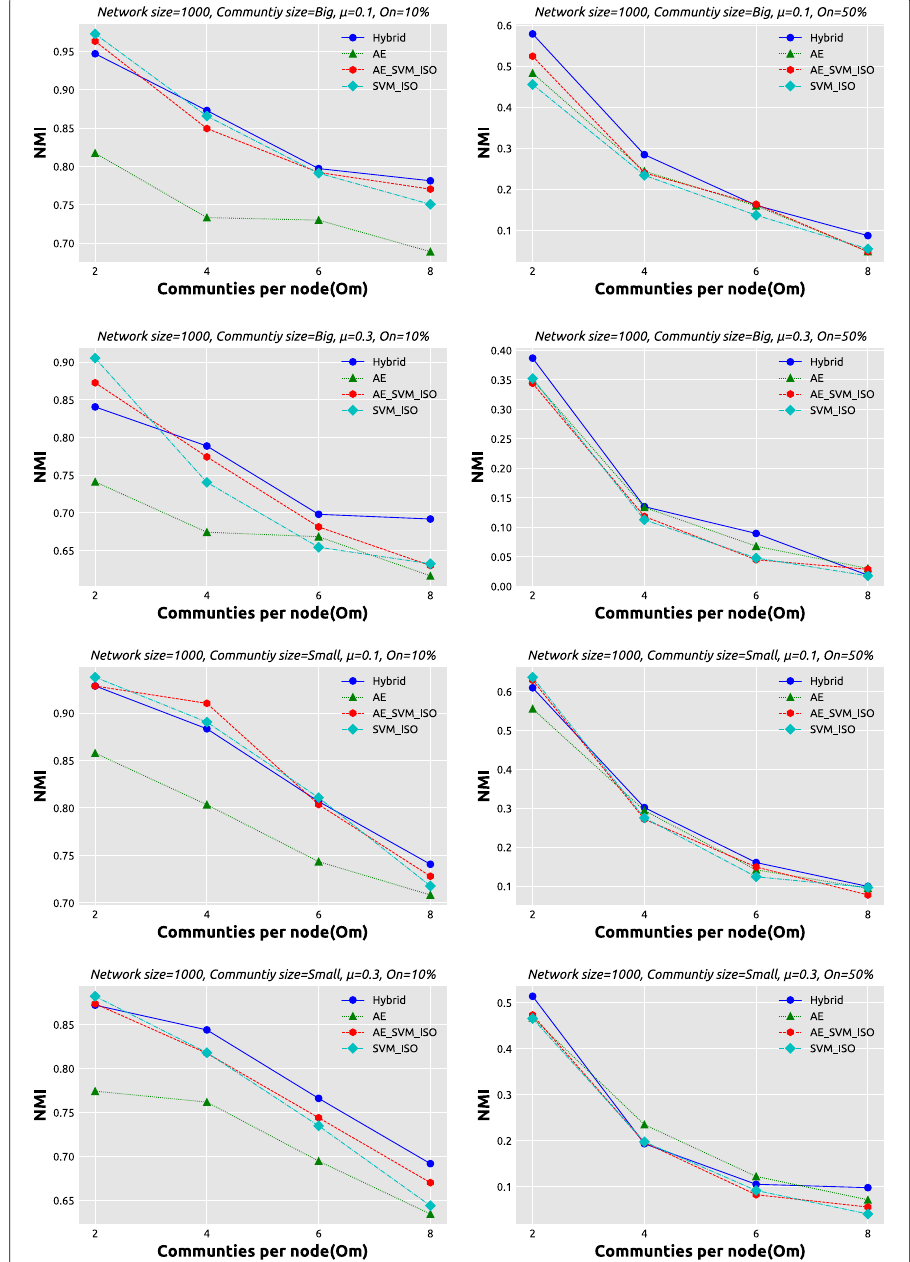
Fig. 7 Performance of AC-SLPA using different constraint cleaning methods on small synthetic networks , containing both small and large communities, where the mixing parameter µ varies from 0.1 to 0.3. NMI values are plotted against the number of communities per node ( O m